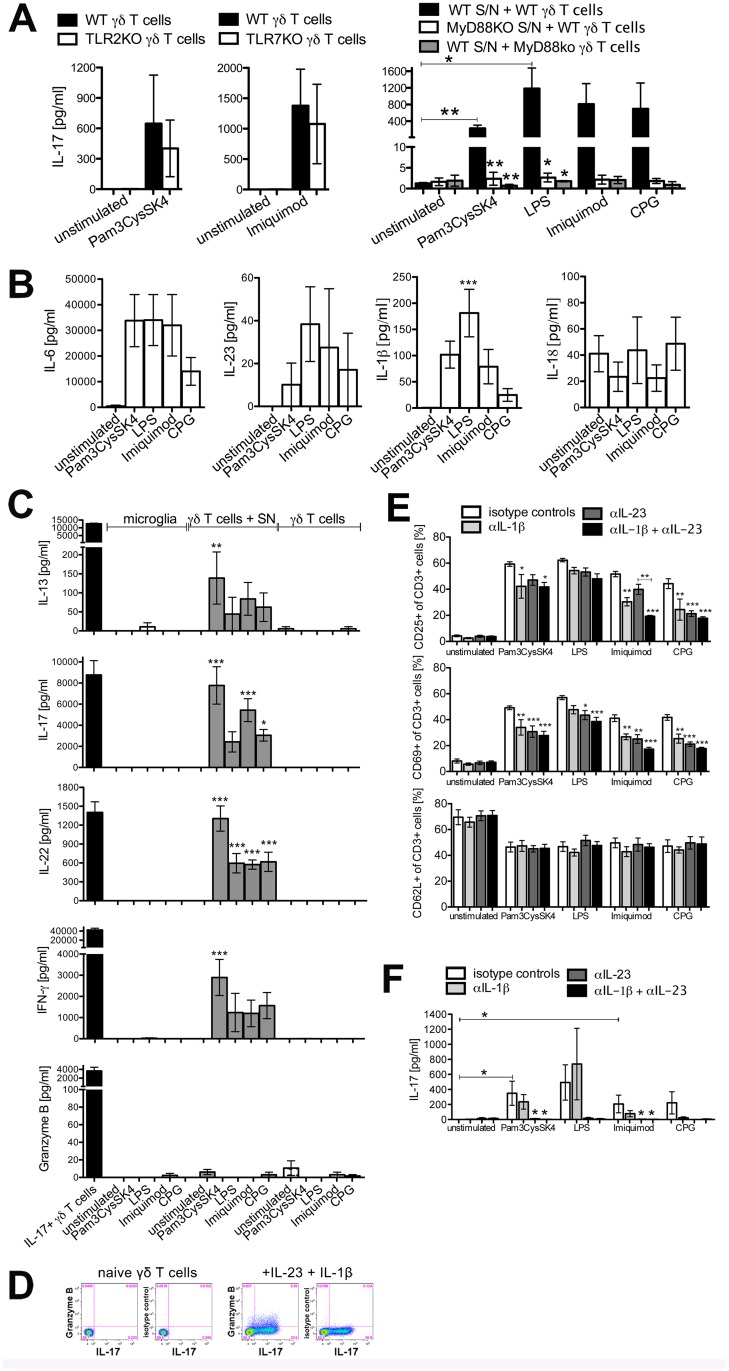
Supernatants from microglia stimulated via TLRs induce activation patterns alike to IL-17+ γδ T cells dependent on MyD88 expressed in microglia and in γδ T cells.
(A) Wild-type (WT) or MyD88KO microglia were stimulated for 24 h with the TLR ligands Pam3CysSK4 (100 ng/ml), LPS (100 ng/ml), imiquimod (10 μg/ml) or CpG (1 μM). Microglia-conditioned supernatants were transferred to freshly isolated naïve WT, TLR2KO, TLR7KO, or MyD88KO γδ T cells. After 3 days, supernatants were collected and analyzed regarding IL-17 by ELISA. Mean ± SEM of 3–4 individual experiments. (B, C) WT microglia were stimulated as in (A) and microglia-conditioned supernatants were either used for cytokine analysis or transferred to freshly isolated naïve γδ T cells. Also, naïve γδ T cells were directly stimulated with TLR ligands as indicated or IL-1β, IL-23, anti-CD3, and anti-CD28. After 3 days, supernatants were analyzed by bead based multiplex assay or ELISA for indicated cytokines. Mean ± SEM of 3 individual experiments. Amounts of IL-1β and IL-18 were analyzed by ELISA for n = 6 individual experiments. (D) Naïve γδ T cells were directly analyzed. In vitro polarized IL-17+ γδ T cells were harvested after 3 days in culture with IL-1β, IL-23, anti-CD3, and anti-CD28, re-stimulated with PMA/ionomycin, and analyzed by flow cytometry for intracellular granzyme B expression. Representative FACS plots of n = 3 individual experiments are shown. (E, F) WT microglia were stimulated as in (A) and microglia-conditioned supernatants were preincubated with 10 μg/ml anti-IL-1β, anti-IL-23 or respective isotype controls before transfer to naïve γδ T cells. After 2 days, γδ T cells were collected and analyzed by flow cytometry regarding CD3, CD25, CD69, and CD62L expression (E). After 3 days supernatants were analyzed by ELISA regarding IL-17 secretion (F). Each condition was performed in duplicate and averaged. Mean ± SEM of 4 individual experiments. (A, B, C, E, F) ANOVA followed by Bonferroni multiple comparison post test, (A) TLR2KO p = 0.3340, TLR7KO p = 0.0989, (B) IL-6 p = 0.0705, IL-23 p = 0.5709, IL-1β p = 0.0011, IL-18 p = 0.7380, (C) IL-13 i = 0.0148, IL-17 p<0.0001, IL-22 p<0.0001, IFN-γ p = 0.0001, granzyme B p = 0.4176, (E) p<0.0001.